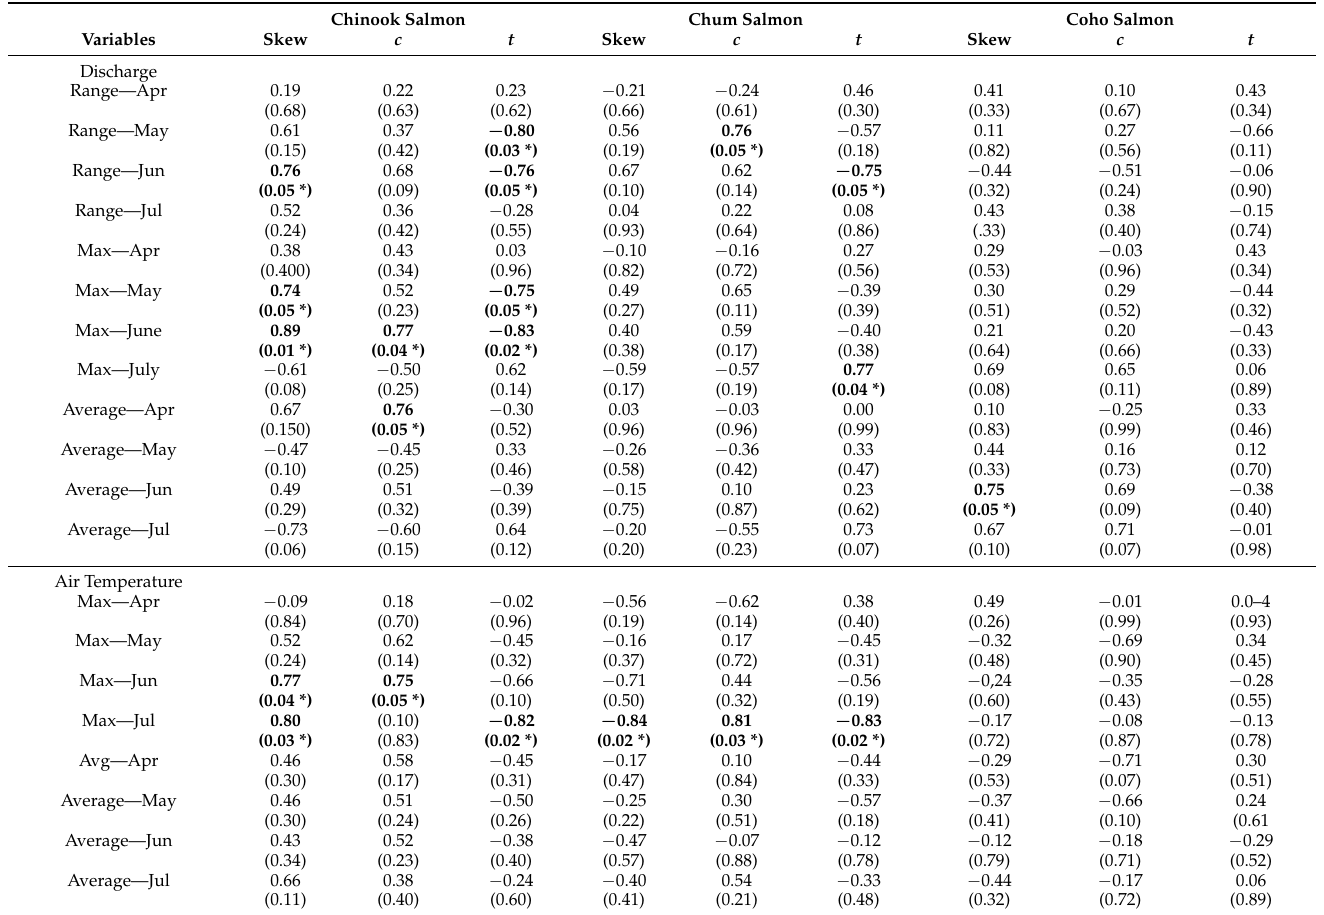
Table 2. Pearson’s correlation coefficients (and significance values) between parameters from nonlin- ear models fitted to juvenile Yukon River salmon migration proportions and variables of discharge and temperature for the years 2014–2019 and 2021. c = spread of the distribution, t = weighted measure of migration duration. Bolded values and asterisks indicate a p -value of 0.05 or lower. Chinook Salmon Chum